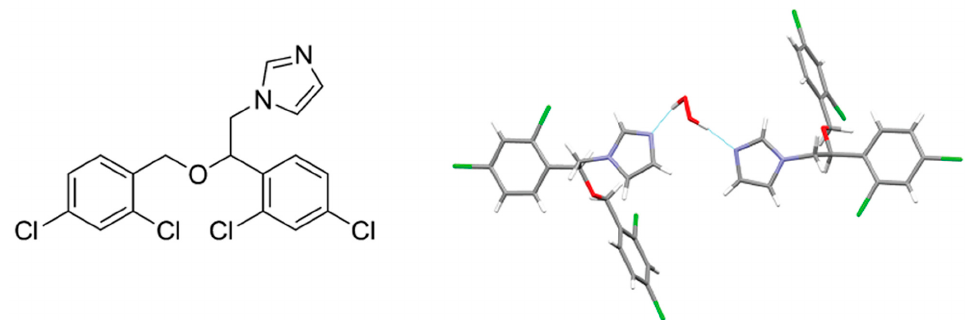
Figure 19. Chemical structure of miconazole (left). Asymmetric cell of the crystal structure of miconazole peroxosolvate [165].